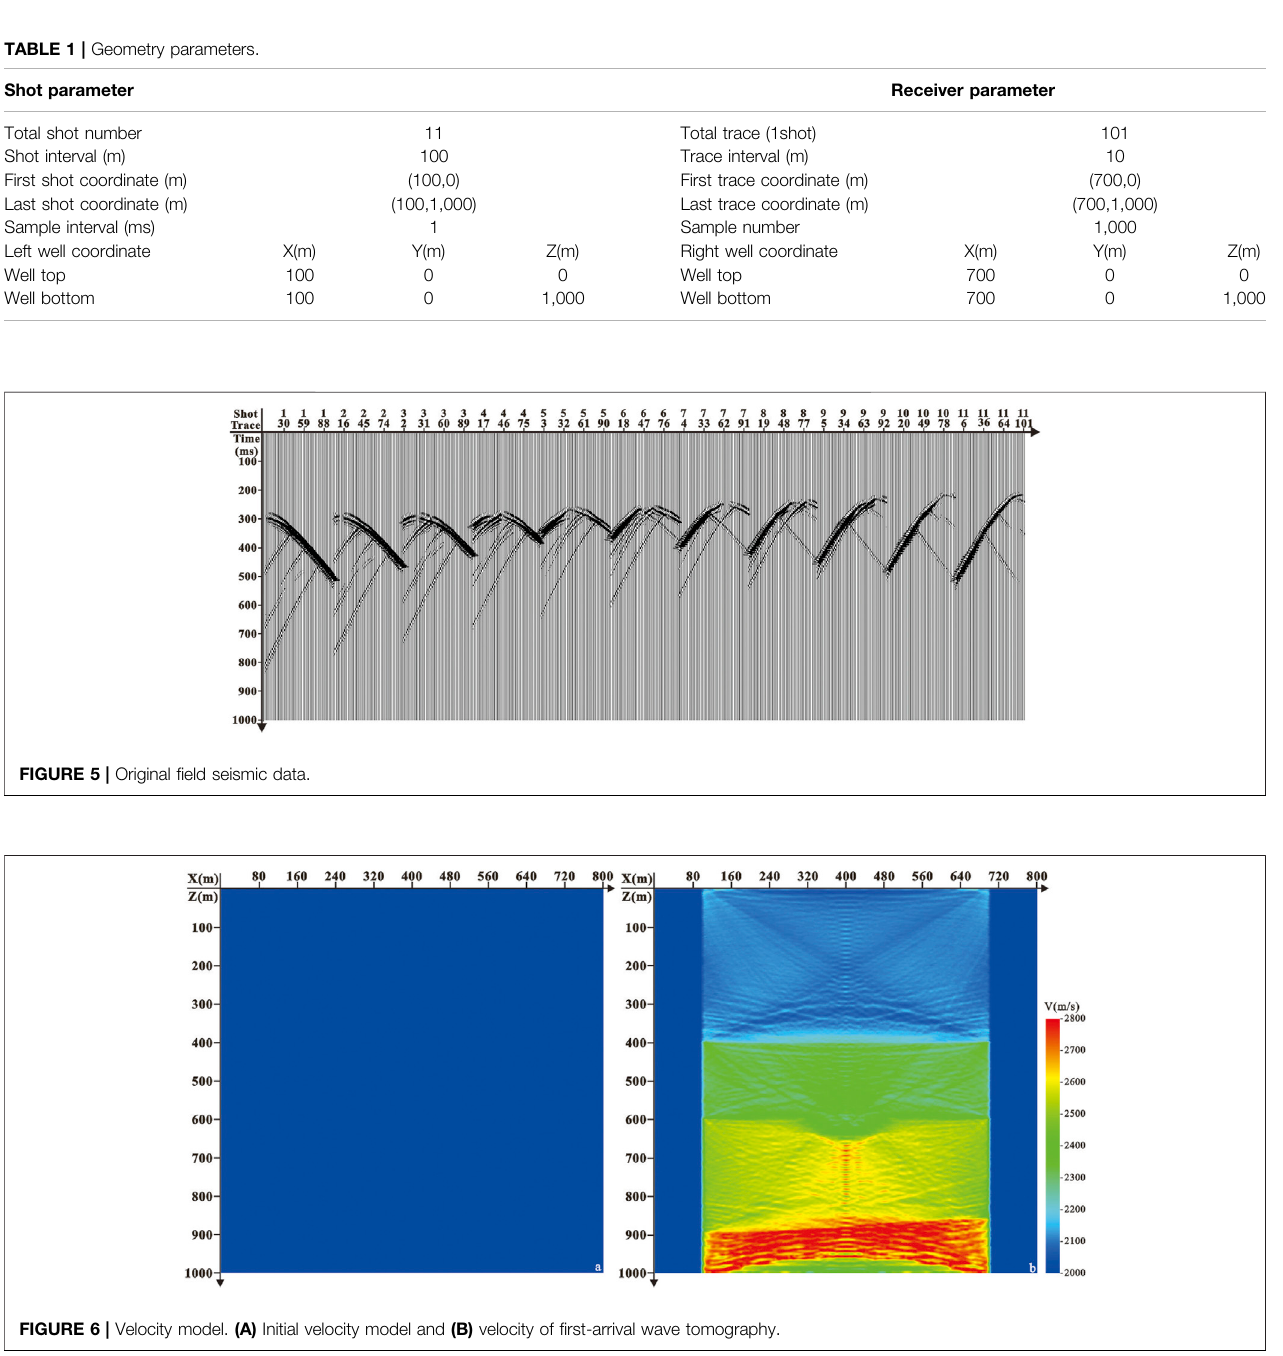
Frontiers in Earth Science |